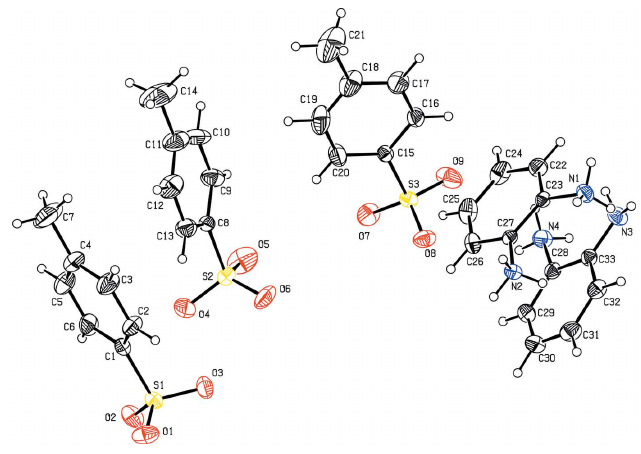
Figure 1 The molecular structure of the title molecular salt, with the atom labelling and 30% probability displacement ellipsoids.